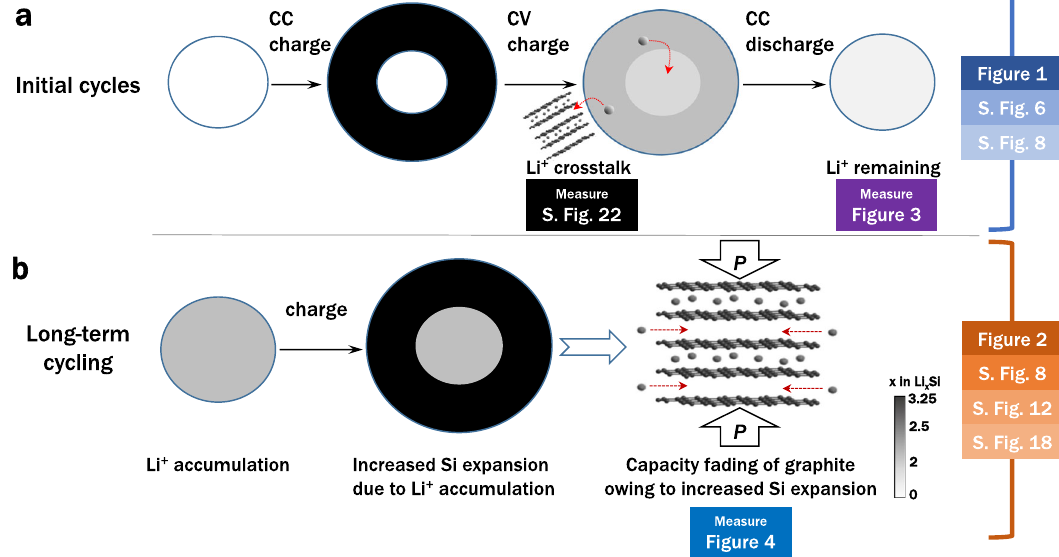
Fig. 5 Schematic of degradation mechanism. a In the initial cycles, two-phase lithiation of silicon particles occurs during constant current (CC) charging owing to hydrostatic stress in the particle, and Li + crosstalk between silicon and graphite occurs during constant voltage (CV) charging. When crosstalk occurs, Li + penetrates into the silicon core and remains after discharging. b During long-term cycling, the accumulation of Li + in the silicon core